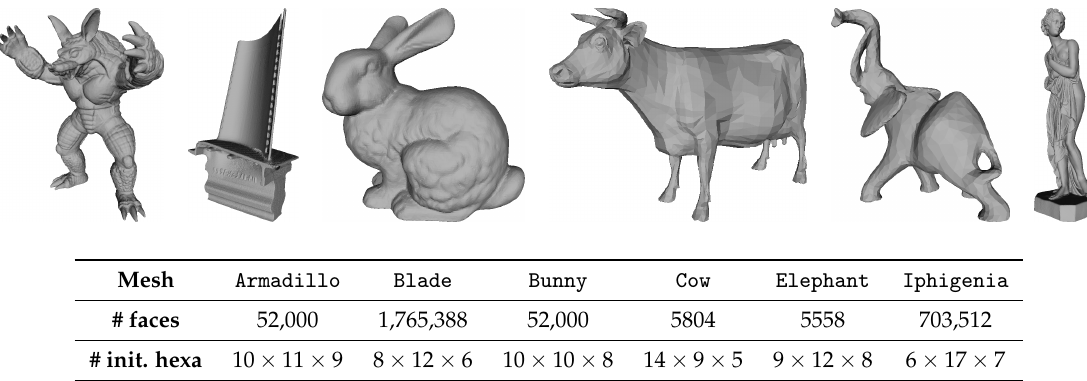
Figure 9. Initial polygon meshes used in our experiments. # faces is the number of faces of the original polygon meshes. # init. hexa is the number of hexahedra in the initial coarse